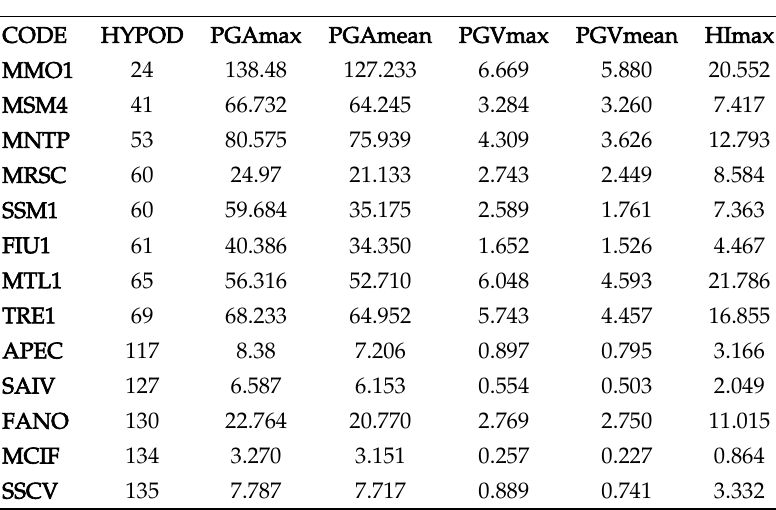
Table 2: Results obtained for seismic stations. Station code (CODE), Hypocentral distance (HYPOD, Km), maximum Peak Ground Acceleration of horizontal components (PGAmax, cm/s^2), geometric mean of Peak Ground Acceleration of horizontal components (PGAmean, cm/s^2); maximum Peak Ground Velocity of horizontal components (PGVmax, cm/s), geometric mean of Peak Ground Velocity of horizontal components (PGVmean, cm/s), maximum value of horizontal components of Housner Intensity (HImax,